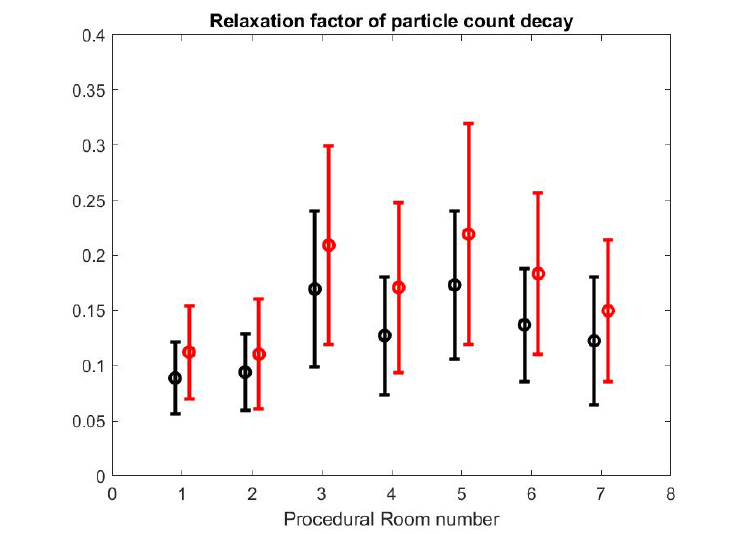
Figure 11. Relaxation factor λ of particle count decay ≈ exp ( − λ t ) for small particles (black) and large particles